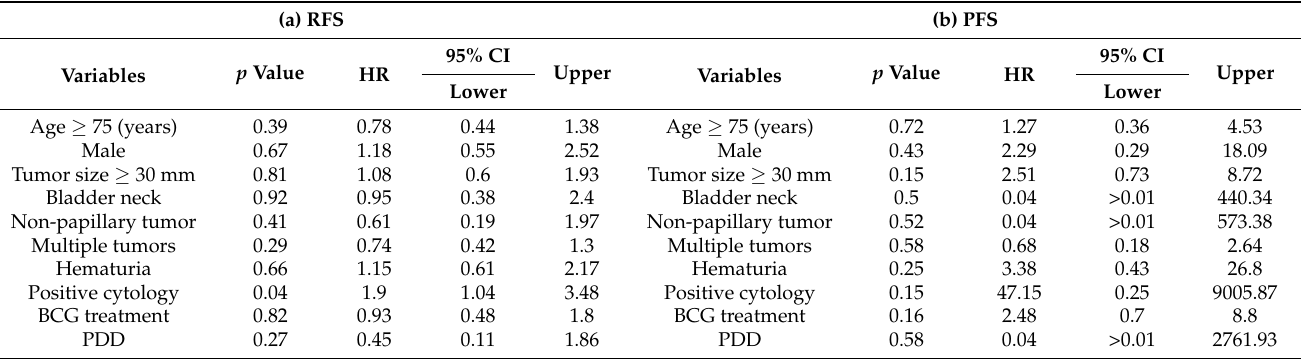
Table 4. Univariate analysis of the prognostic factors for recurrence-free survival and progression-free survival of patients with NMIBC with positive inchworm sign.